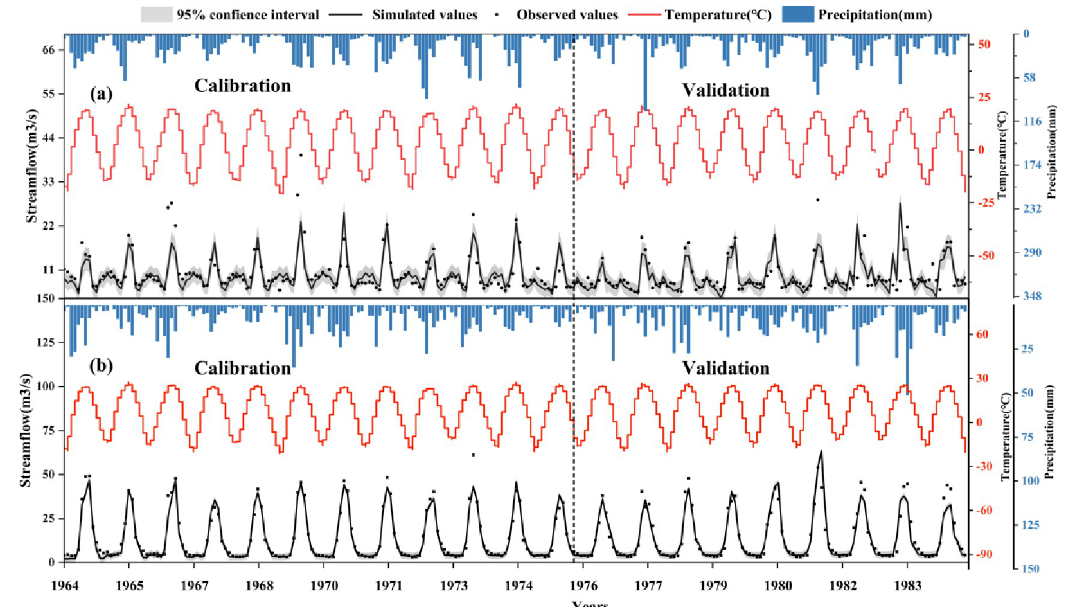
Fig 3. Comparison of simulated streamflow with observed streamflow from two hydrological stations, detailed model performance is shown.